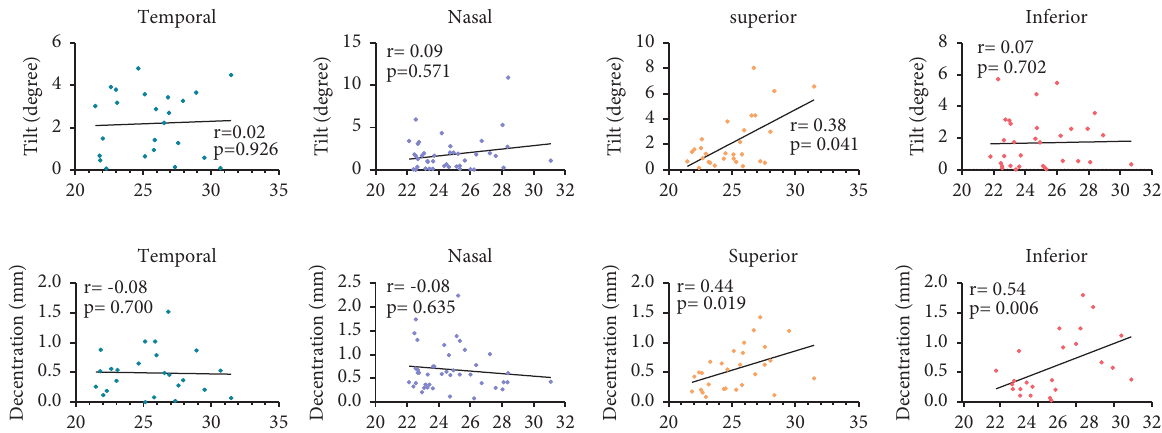
Figure 4: The scatter plots show the correlations between IOL position and AL at different